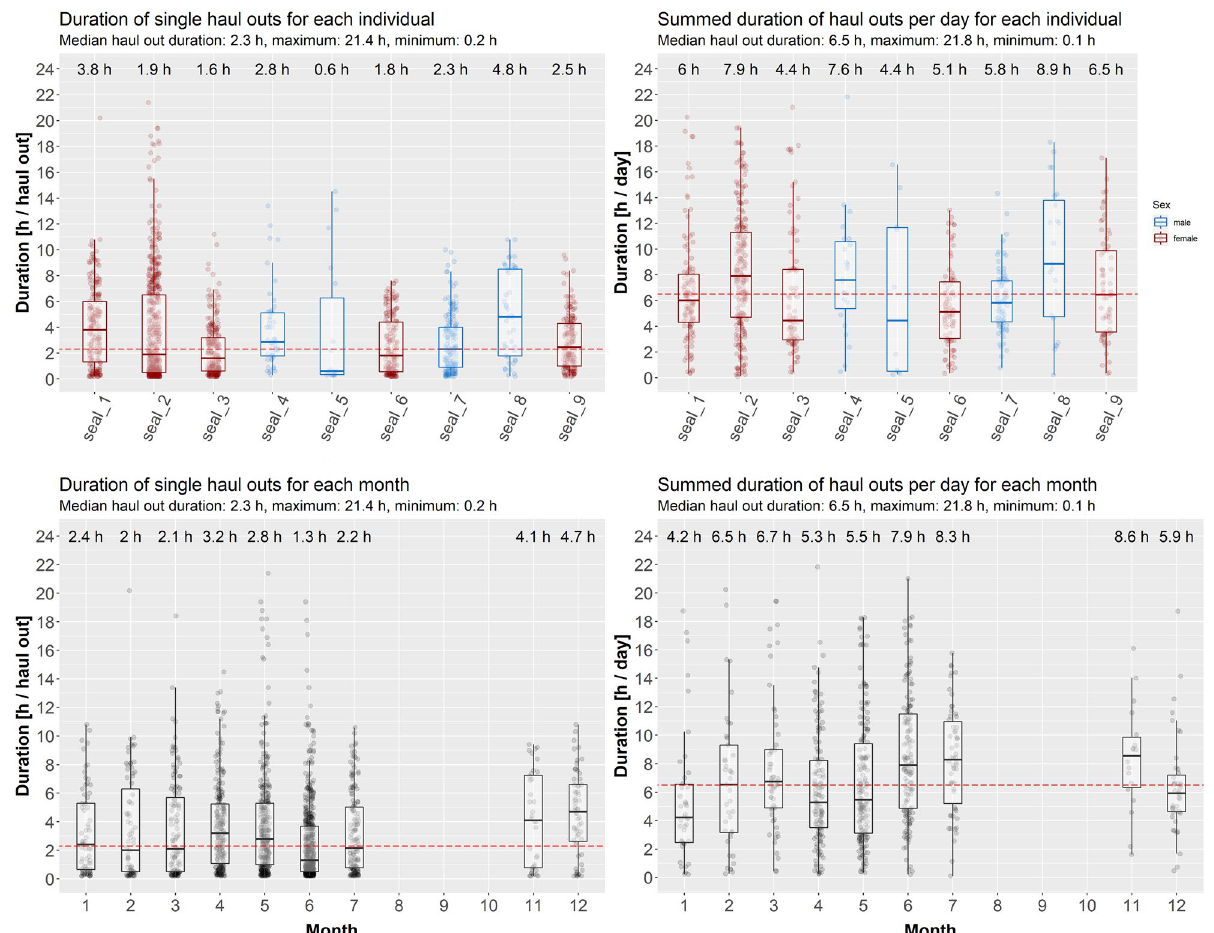
Figure 6. Box plots showing the duration of haul outs for each individual (top row) and each month of the year (bottom row) comparing the duration of single haul out events (left column) with cumulative haul out duration for each day (right column). Boxes represent the 25th and 75th percentiles, the bar the median and whiskers extend from the hinge to the largest or smallest value but no further than 1.5 * the inter-quartile range. The x-axis shows the seal